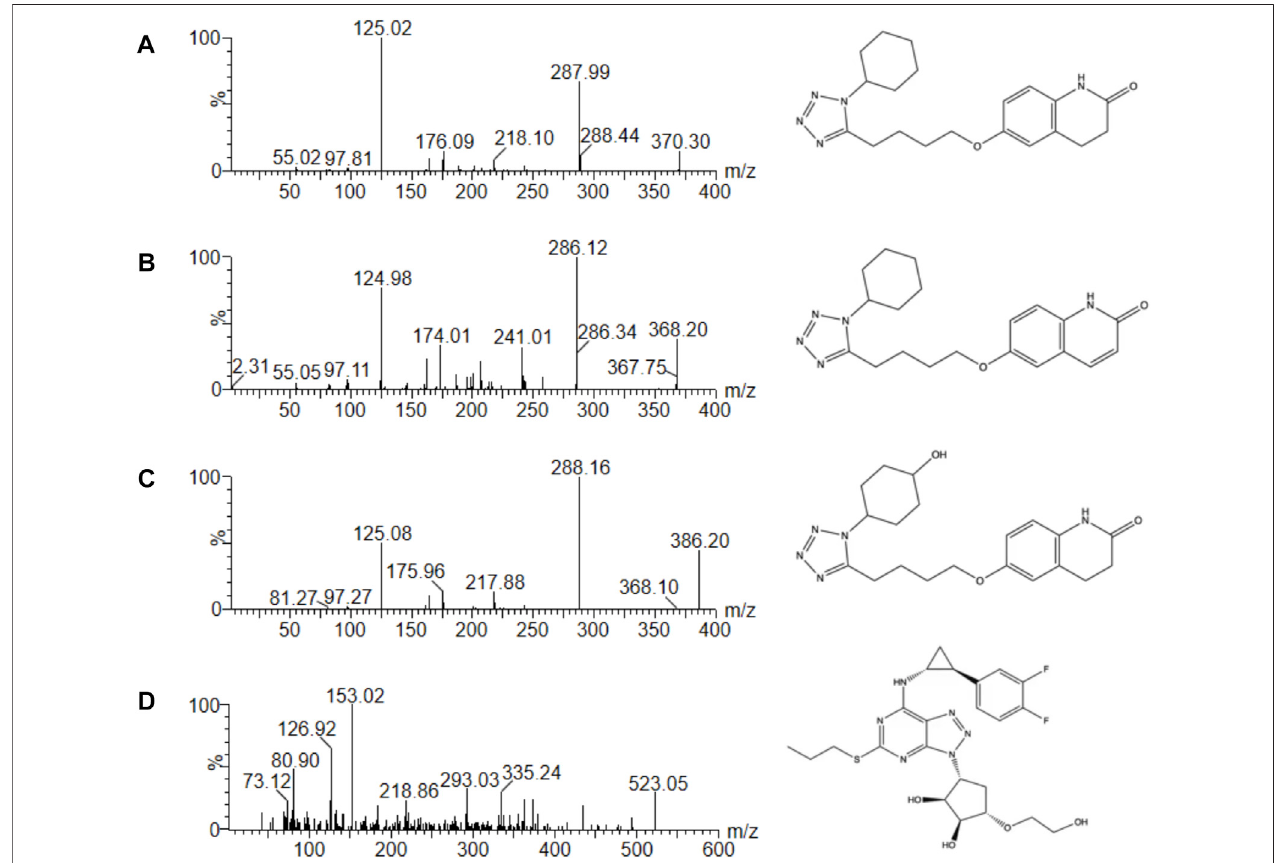
FIGURE 1 | Mass spectra of cilostazol (A) , 3,4-dehydro cilostazol (B) , 4 ′ -trans-hydroxy cilostazol (C) and IS (D) in this